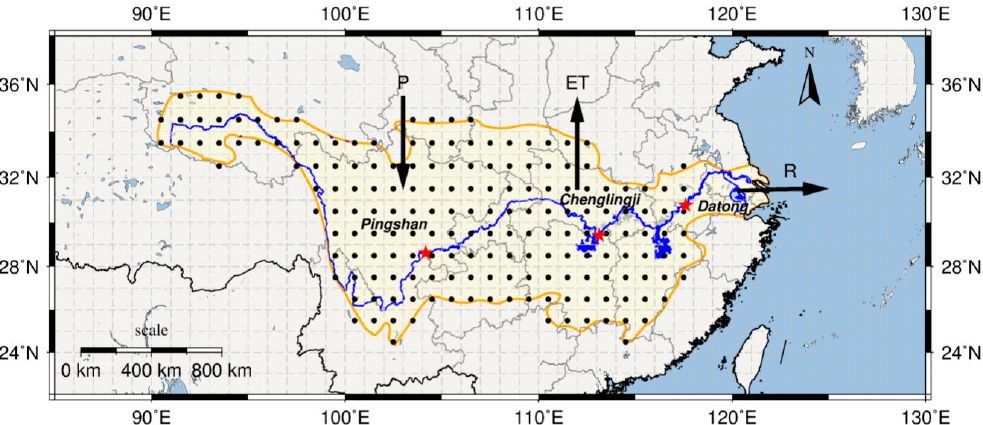
Figure 1. Map of the Yangtze River basin (YRB). Selected hydrological stations (red stars), which collected precipitation, evaporation, and discharge data time series, are situated along the upper, middle, and lower reaches of the Yangtze River. The point locations (black dots) correspond to grid values included in the estimated basin-averaged runoff.